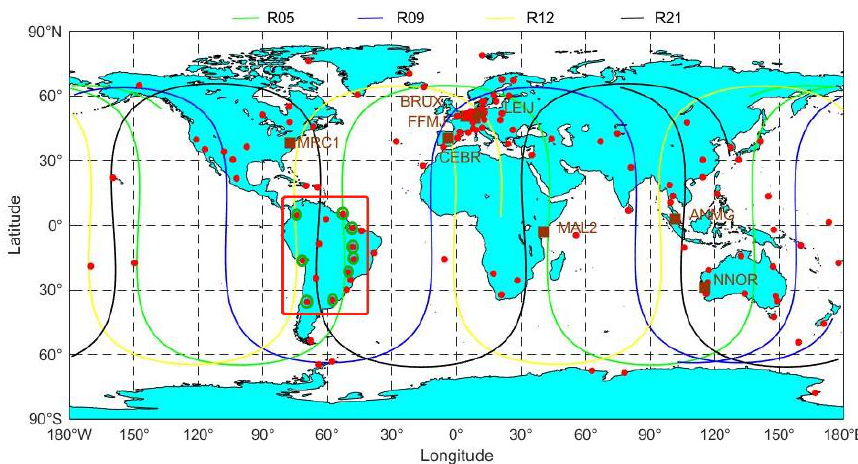
Figure 1. The distribution of 145 MGEX stations with GLONASS triple-frequency observations used in the experiment. The globally-distributed red points and brown squares represent stations that were used to model the code pseudorange variations and validate the established correction model. Ground tracks of R05, R09, R21, and R26 are given, and different color line denotes the ground track of different satellite.